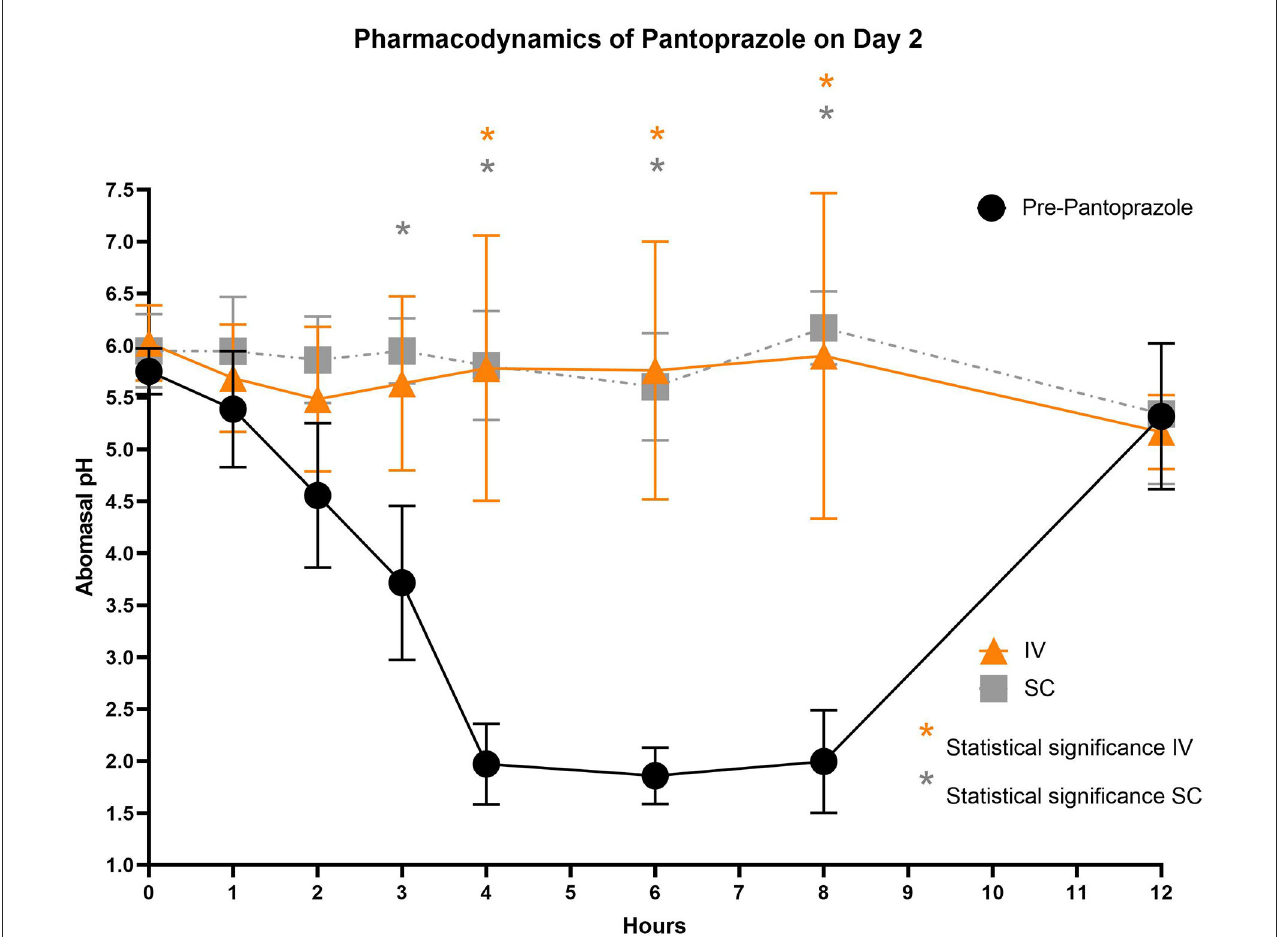
FIGURE4 Comparison of abomasal pH over time between control, IV, and SC treatment groups on Day 2. Black circles, pH pre-pantoprazole administration; Orange triangles, pH after IV pantoprazole administration; Gray square, pH after SC administration. Statistical significance ( P < 0.05) noted with